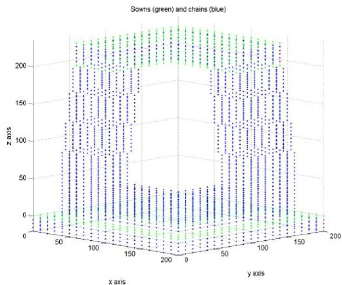
Figure 11. Preliminary distinction between